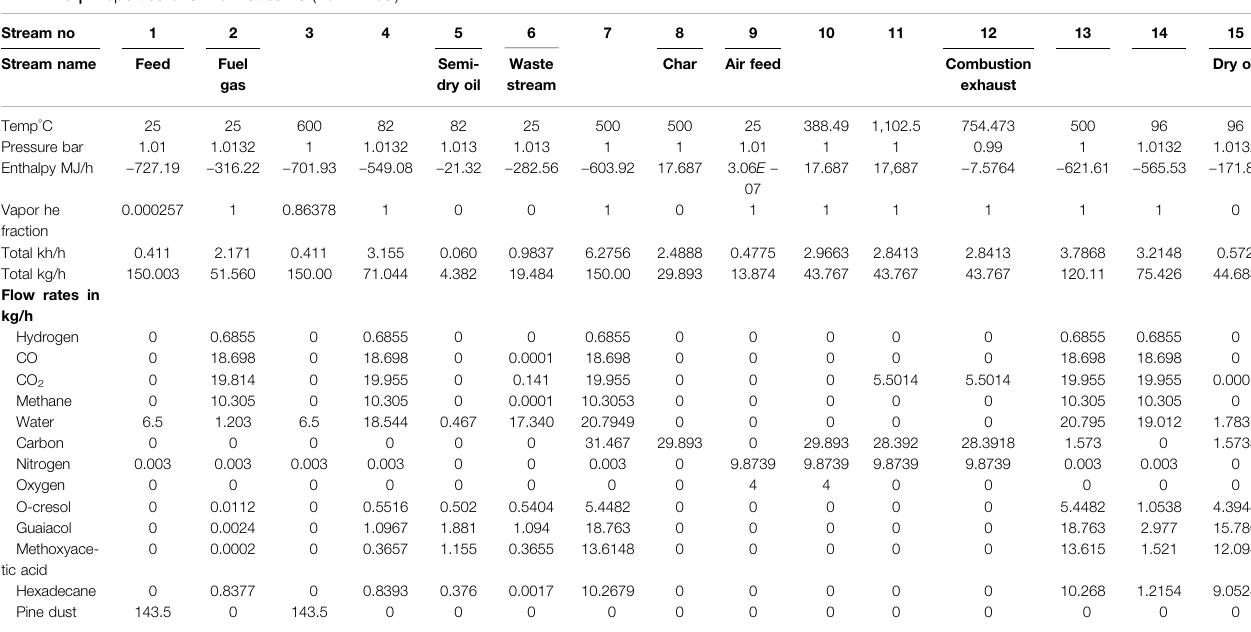
TABLE 5 | Properties of all fl ow streams (from Excel). Stream